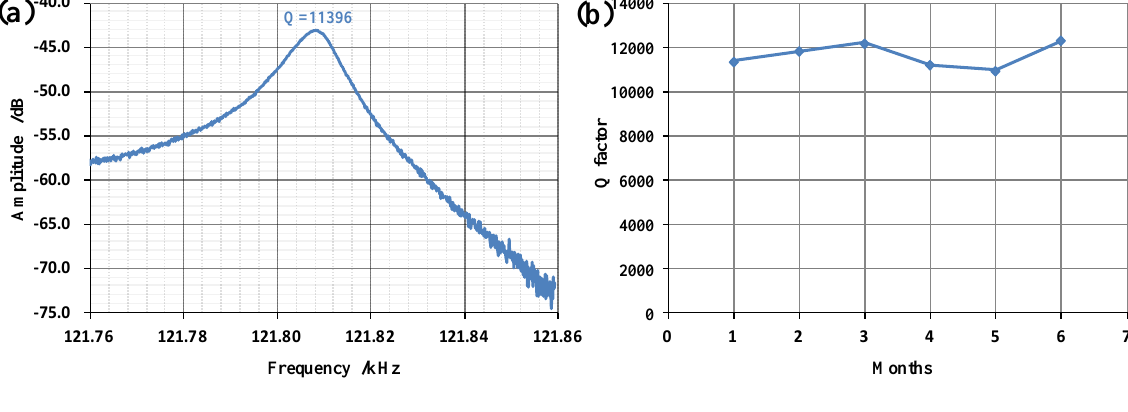
Figure 6. ( a ) The quality factor of the proposed pressure micro sensor was quantified as 11,396; ( b ) The quality factor was higher than 10,000 within six months of